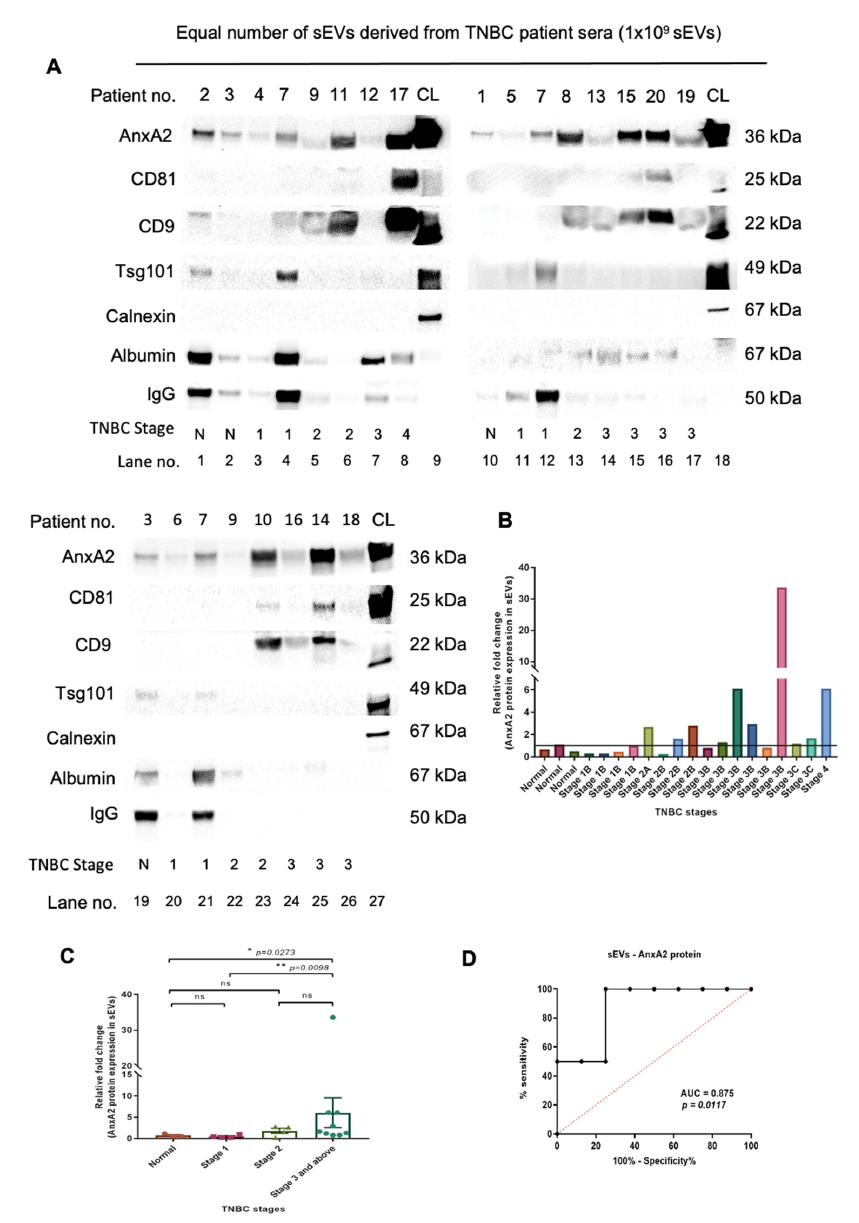
Figure 3. Later stages of TNBC are marked with increased expression of the sEV-derived AnxA2 protein in TNBC patients and it is significantly associated with responsiveness to the chemotherapy. ( A ) Western blot showing AnxA2 protein expression in the equal number of sEV-derived from TNBC patient serum according to the stages of cancer, CL, cell lysate. The patient information corresponds to the patient number as described in Table 3 (normal samples—1,2,3; the patient numbers with stage 1-no chemotherapy-4,5,6,7; stage 2-no chemotherapy-8,10, and 11; stage 2 with chemotherapy—9; stage 3 and above-no chemotherapy-14; stage 3 and above with chemotherapy-12,13,15,16,17,18,19,20). ( B ) The graphical representation of the increased sEV-AnxA2 protein expression in the fold change compared to the stage 1 samples. The patients are as described in Table 3 from 1–20. ( C ) The graphical representation of the mean fold change of the AnxA2 protein expression in the sEV-derived from the TNBC patients from each stage. (mean ± SEM, n = 3 for normal samples, n = 4 for stage 1, n = 4 for stage 2, and n = 9 for stage 3 and above; ** p < 0.01, * p < 0.05). ( D ) ROC curve for serum sEV-derived AnxA2 protein as a biomarker alone for the prediction of responsiveness or non-responsiveness to neoadjuvant chemotherapy in patients with stage 3 and above (n =